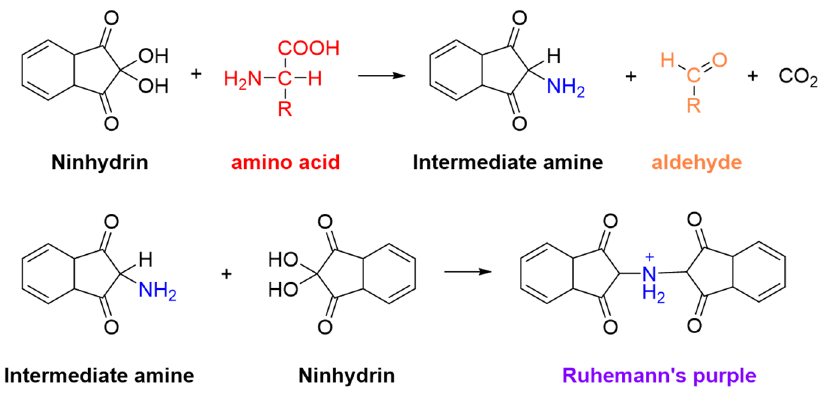
Figure 1. Mechanisms of reactions of α -amino acids with ninhydrin to form Ruhemann’s purple.